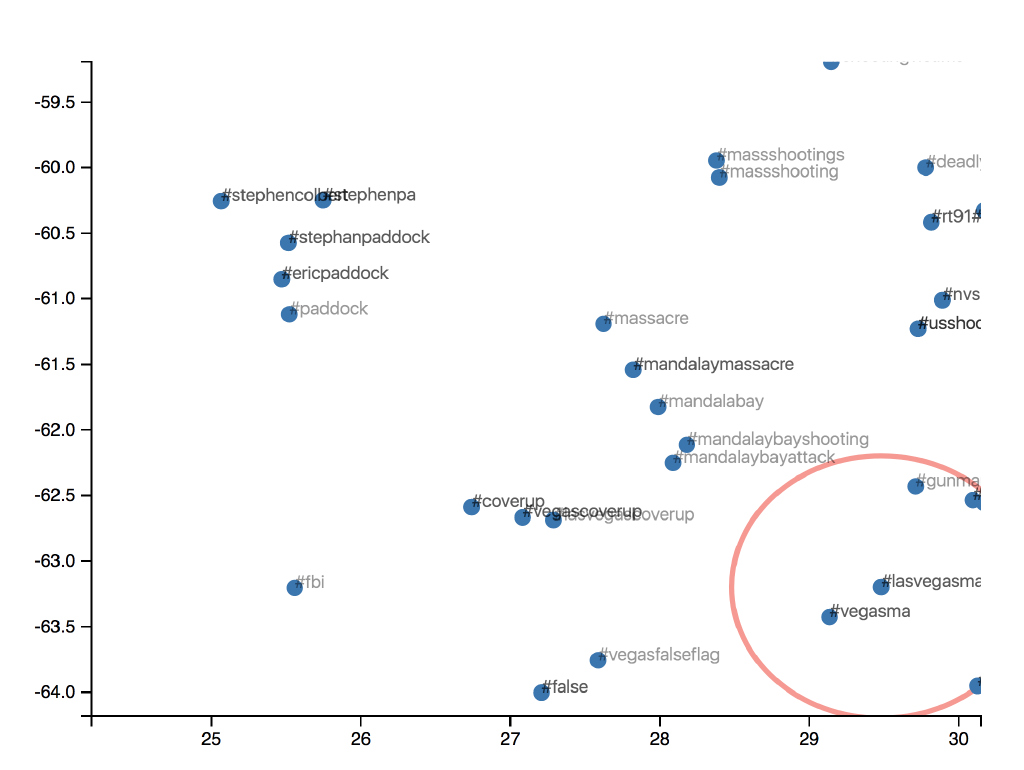
Figure 6. As the user interacts with the plot using simple actions like scrolling and zooming, more details start emerging in an unsupervised